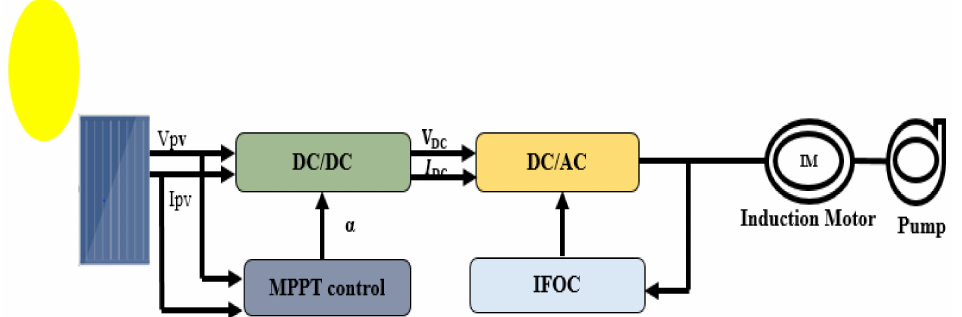
Figure 1. Functional principle of a solar